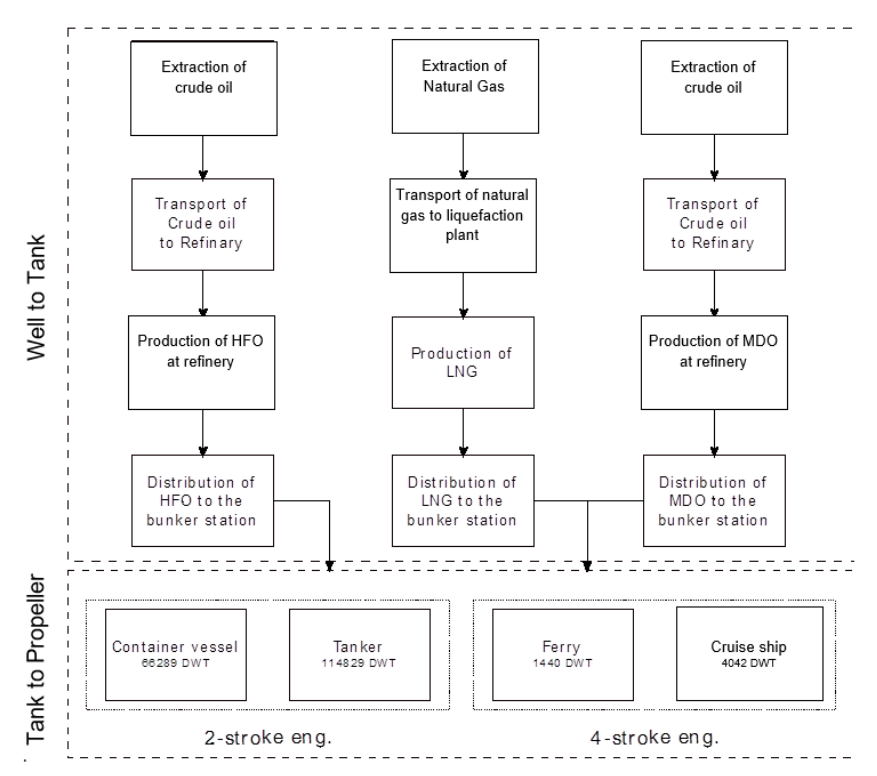
Figure 1. System Figure 1. System boundaries.